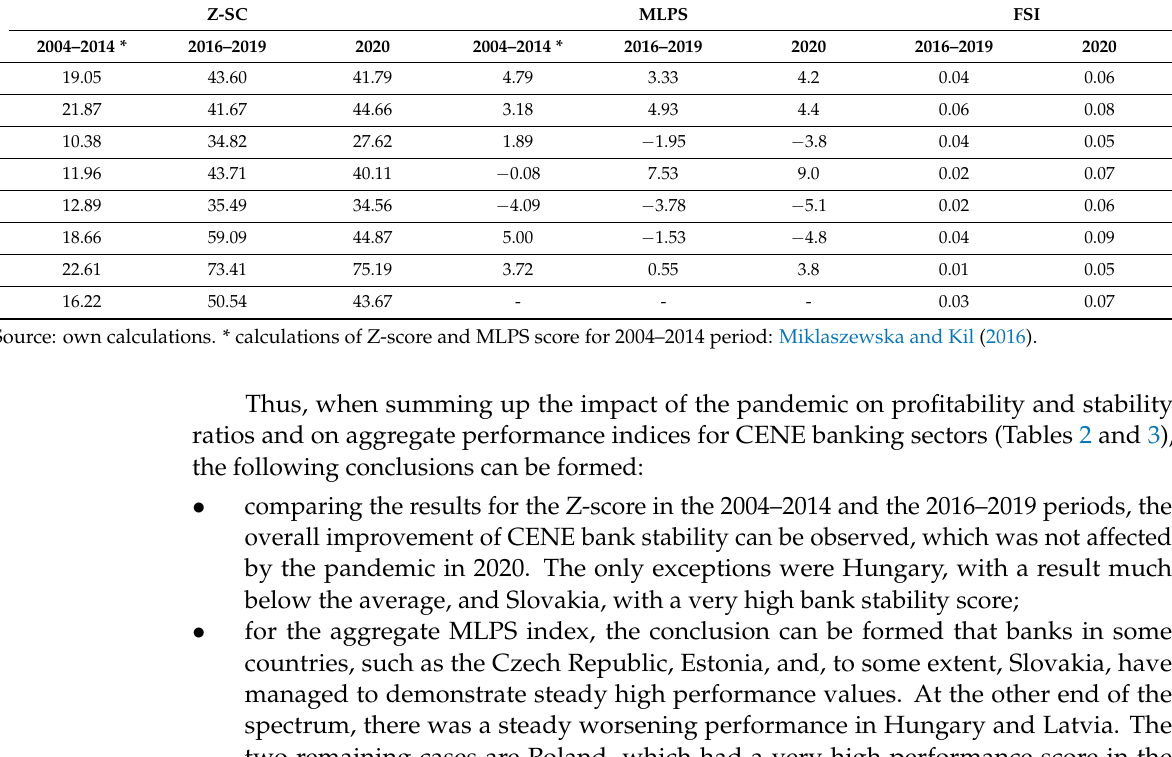
Table 3. The average results for CENE banks: stability and synthetic performance indicators. Z-SC MLPS Country